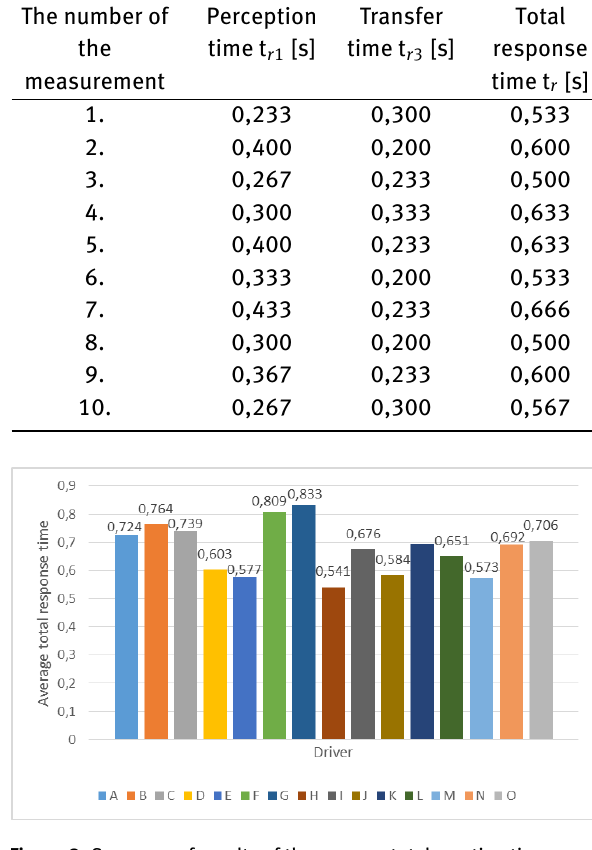
of 0.171 s indicating a high time dispersion. The most re- peatable measurements were observed during the passage of driver E, whose average total reaction time was 0.577 s with a deviation equal to 0.059 s. The most repeatable mea-